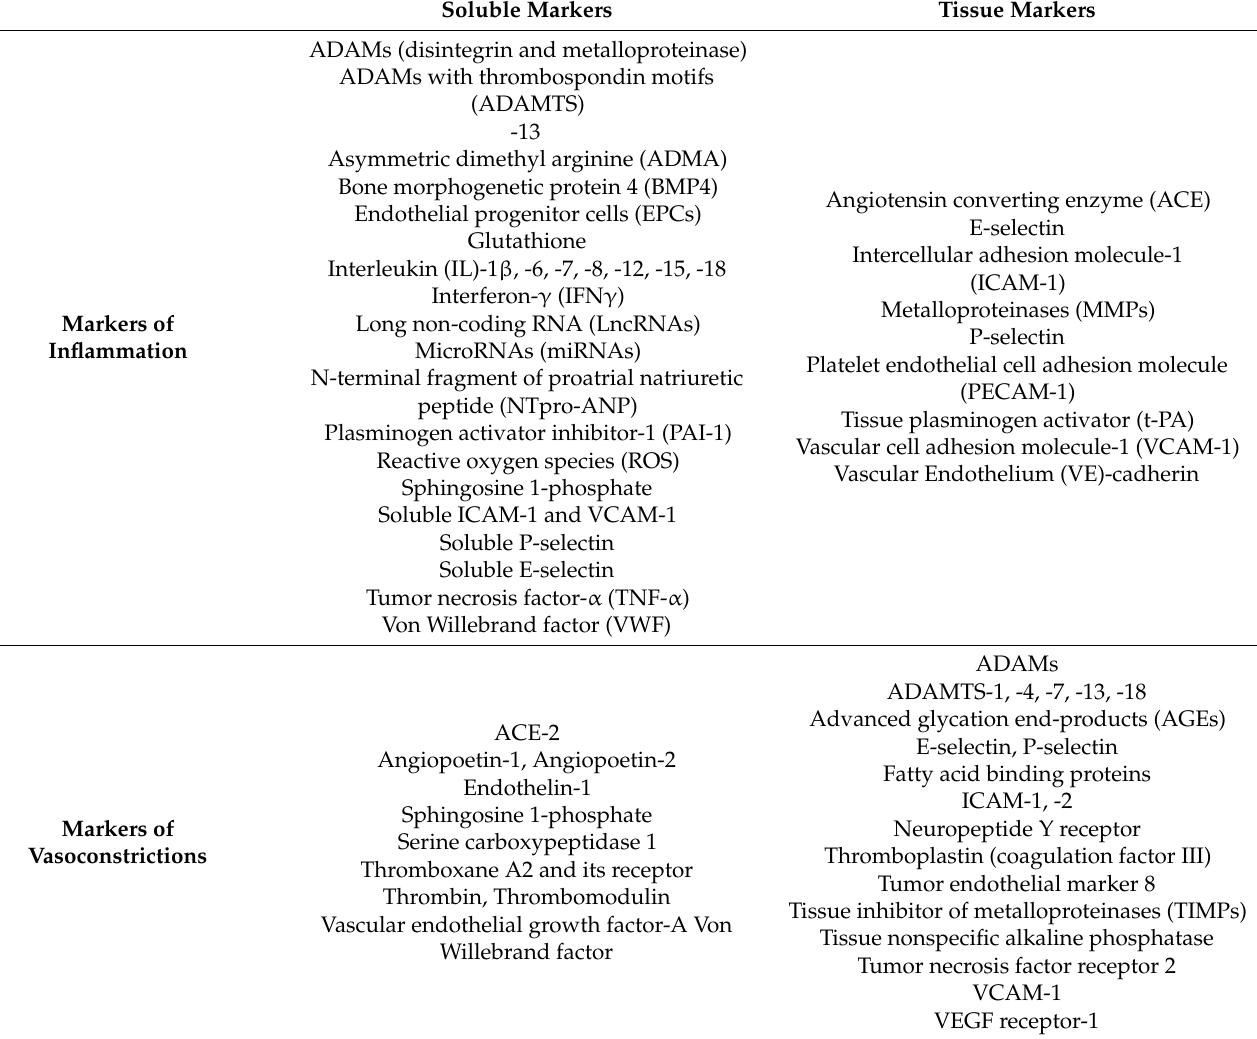
Table 2. Markers of endothelial dysfunction commonly used in research setting. Soluble Markers Tissue